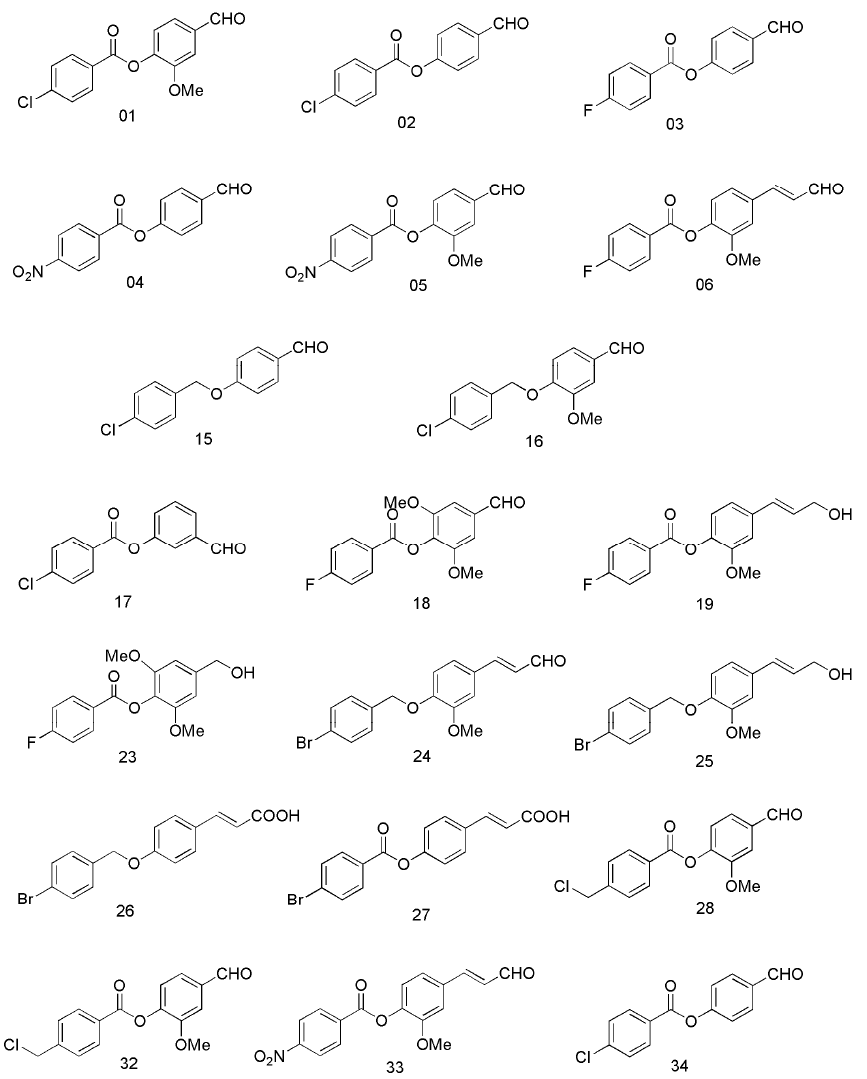
Figure 1. Chemical structures of ALDH-affinic compounds, adapted from Ibrahim et al. [21].